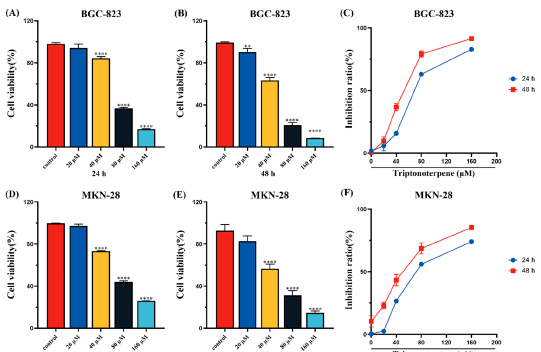
Figure 1. Cell viability was detected using the CCK ‐ 8 assay. ( A , B ) The survival rates of the BGC ‐ 823 cells after 24 h and 48 h interventions with different concentrations of Triptonoterpene. ( C ) The in ‐ hibitory rates of Triptonoterpene on the BGC ‐ 823 cells after 24 h and 48 h. ( D , E ) The survival rates of the MKN ‐ 28 cells after 24 h and 48 h interventions with different concentrations of Triptonoter ‐ pene. ( F ) The inhibitory rates of Triptonoterpene on the MKN ‐ 28 cells after 24 h and 48 h. ** p < 0.01 and **** p < 0.0001.